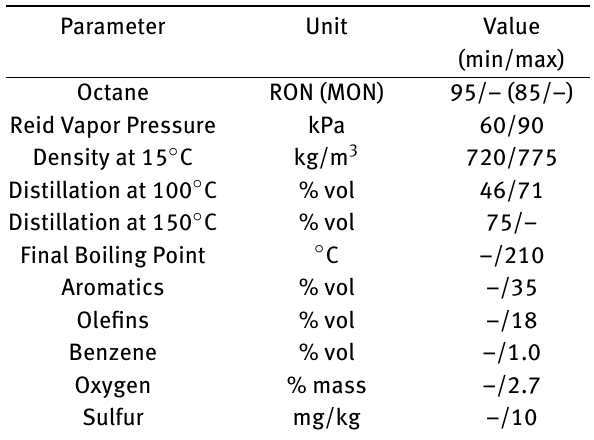
Table 2: Properties of unleaded gasoline fuel EuroSuper 95 (petrol E5)